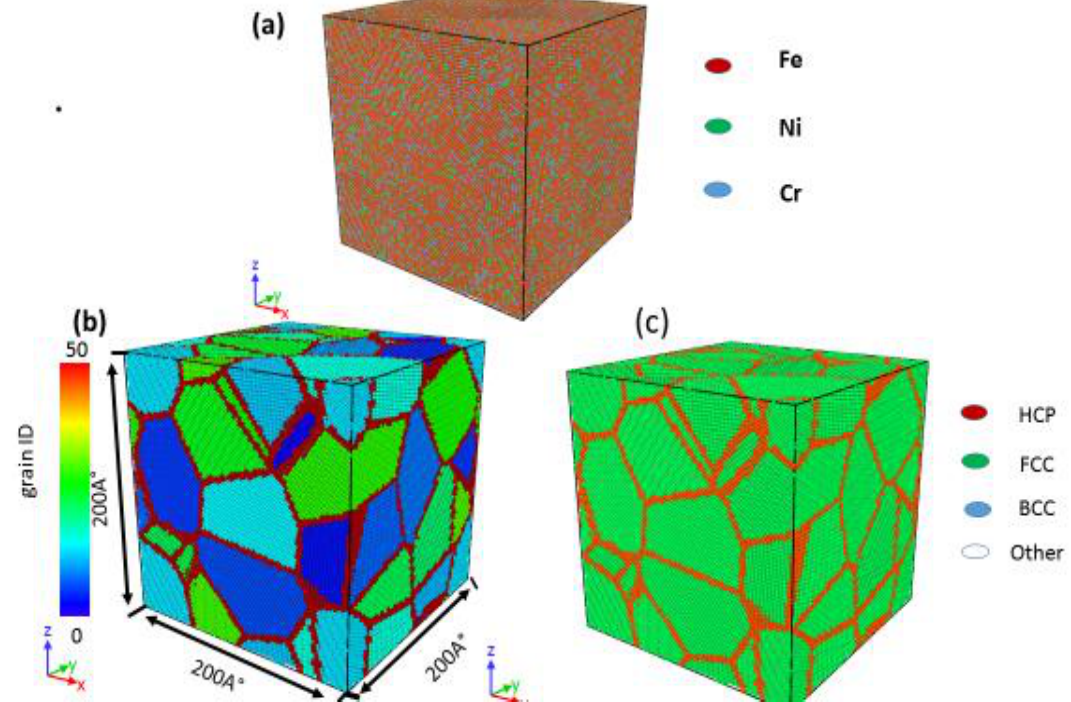
Figure 1. Initial configuration of the polycrystalline stainless-steel alloy with an average grain size of 2.5 nm. ( a ) Element container, ( b ) grain identity number, and ( c ) common neighbor analysis.